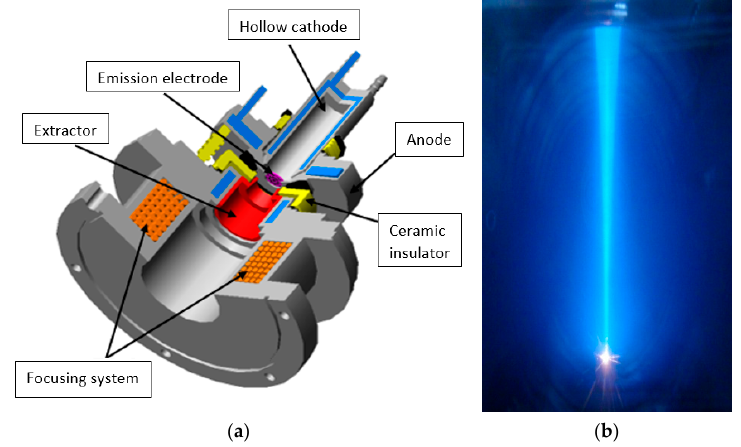
Figure 12. Electrode diagram of the electron source ( a ) and a photograph of the electron beam ( b ) [101]. The hollow cathode of the discharge system of the plasma electron source is made of stainless steel; its diameter is 15–30 mm and length 40–60 mm. The flat anode is also made of stainless steel. Electrons are extracted from the plasma through an emission window of a diameter of about 10 mm cut in the anode. To stabilize the plasma emission surface and ensure the stable operation of the electron source, the emission window is draped with a fine-structured tungsten grid with high geometric transparency, or a per- forated tantalum electrode is used. The electron beam is focused by a magnetic lens. In the operational pressure range of the forevacuum plasma electron source, a hol- low cathode discharge current can amount to 1.0–1.5 A at a burning voltage of 500–600 V. As of today, maximal parameters of the forevacuum plasma electron source of a con-